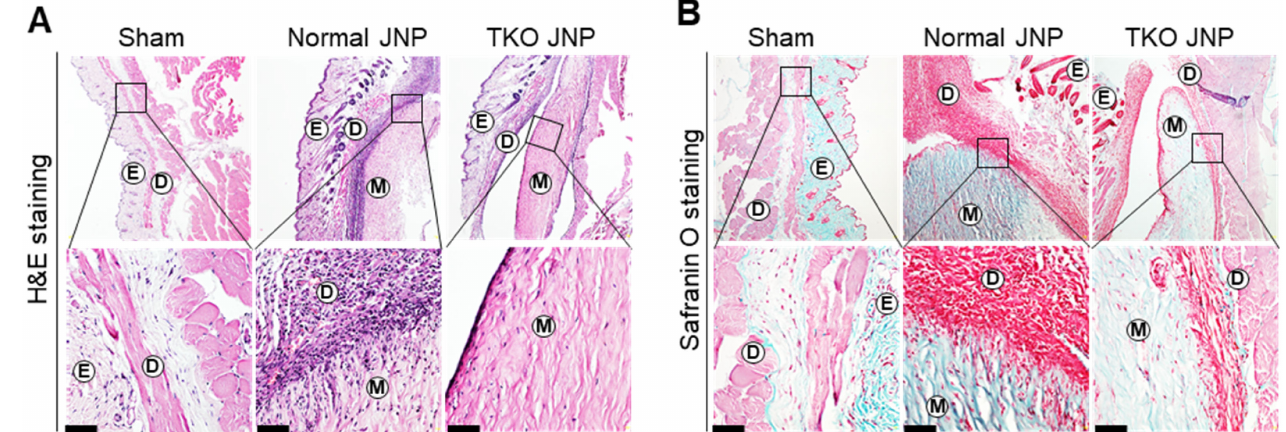
Figure 2. Histological analysis of infiltrated cells in the sham, normal, and TKO JNP groups. The meniscus is extracted from the normal and TKO JNP groups and was cut into sections of approxi- mately 50 mm 3 . The meniscus was transplanted in the dorsal back dermis of mice. The mice were bred for about three weeks. The mouse dermis containing the pig meniscus and sham was examined by H&E ( A ) and Safranin O staining ( B ). E: epidermis; D: dermis; M: meniscus. Magnification (upper panel: 100X, lower panel: 400X). Scale bars: 50 µ